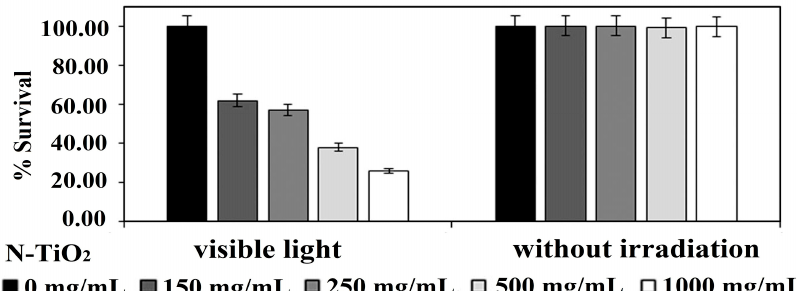
Figure 24. Photocatalytic inactivation of E. coli with N-doped TiO 2 NPs of different concentrations